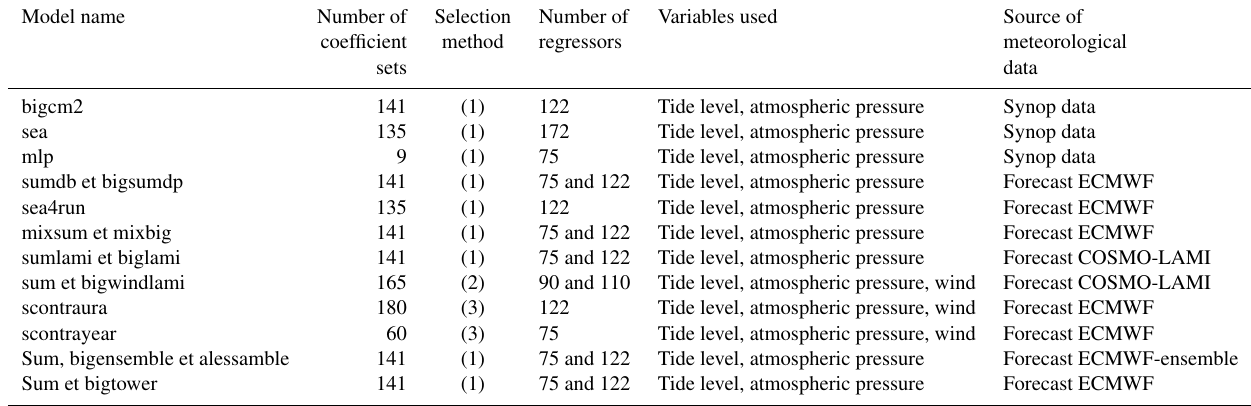
Table 1. List of statistical models running at CPSM. The sets of coefficients are selected depending mainly on (1) maximum atmospheric pressure gradient between opposite coasts of the Adriatic Sea, seasonality; (2) classes of sirocco wind along the four region of Adriatic Sea, seasonality; and (3) classes of sirocco wind and bora wind along the multiple regions of Adriatic Sea,